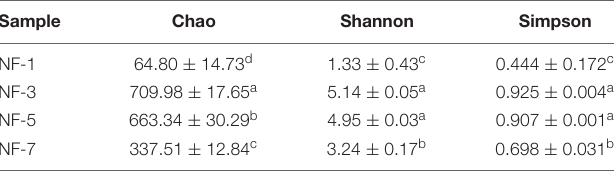
TABLE 1 | Sour porridge microbiota diversity